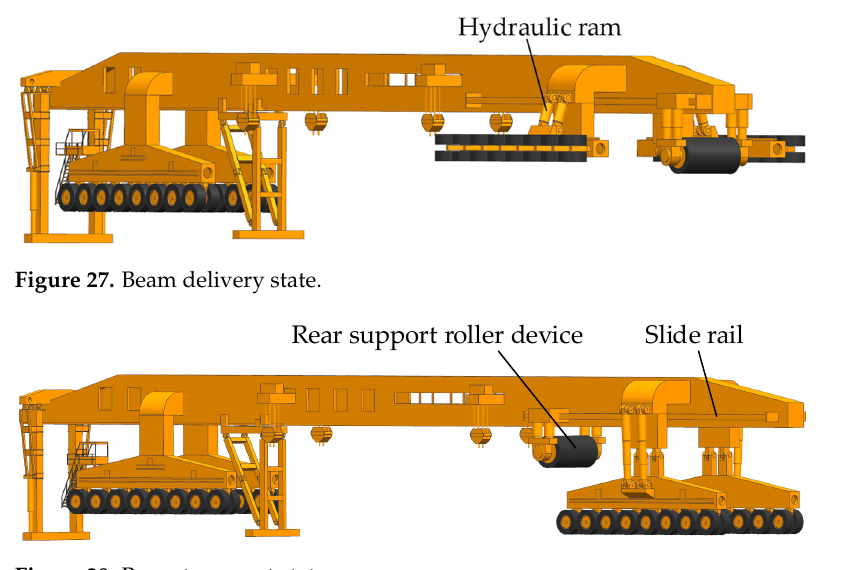
Figure 28. Beam transport state.